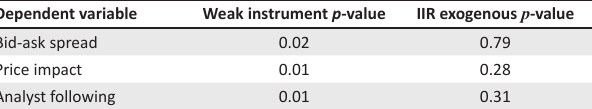
TABLE 6: Wu-Hausman results: Internet investor relations as independent variable and information asymmetry as dependent variable. Dependent variable Weak instrument p -value